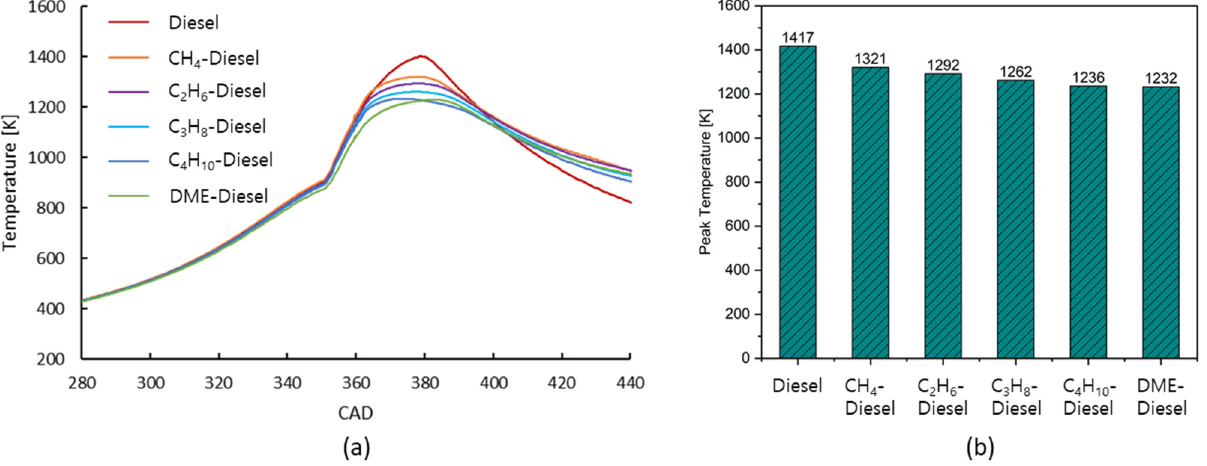
Figure 12. Mean in-cylinder temperature ( a ) and maximum in-cylinder temperature ( b